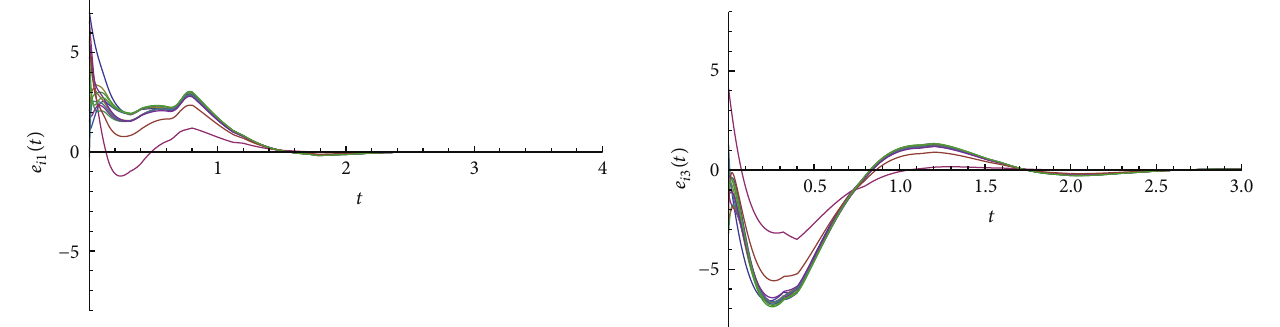
Figure6:Synchronouserror 𝑒 𝑖3 (𝑡) ofcomplexdelayednetwork(26).